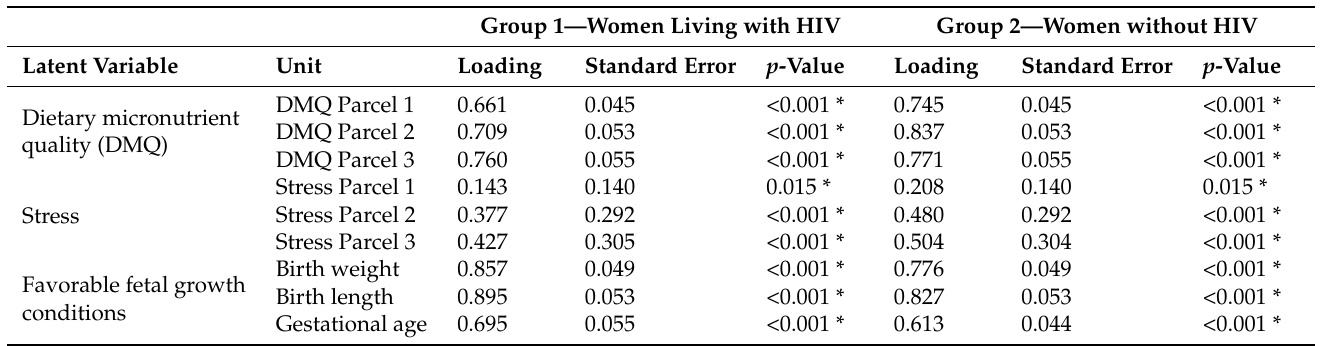
Table 2. Relationships between the latent variables and their indicators.